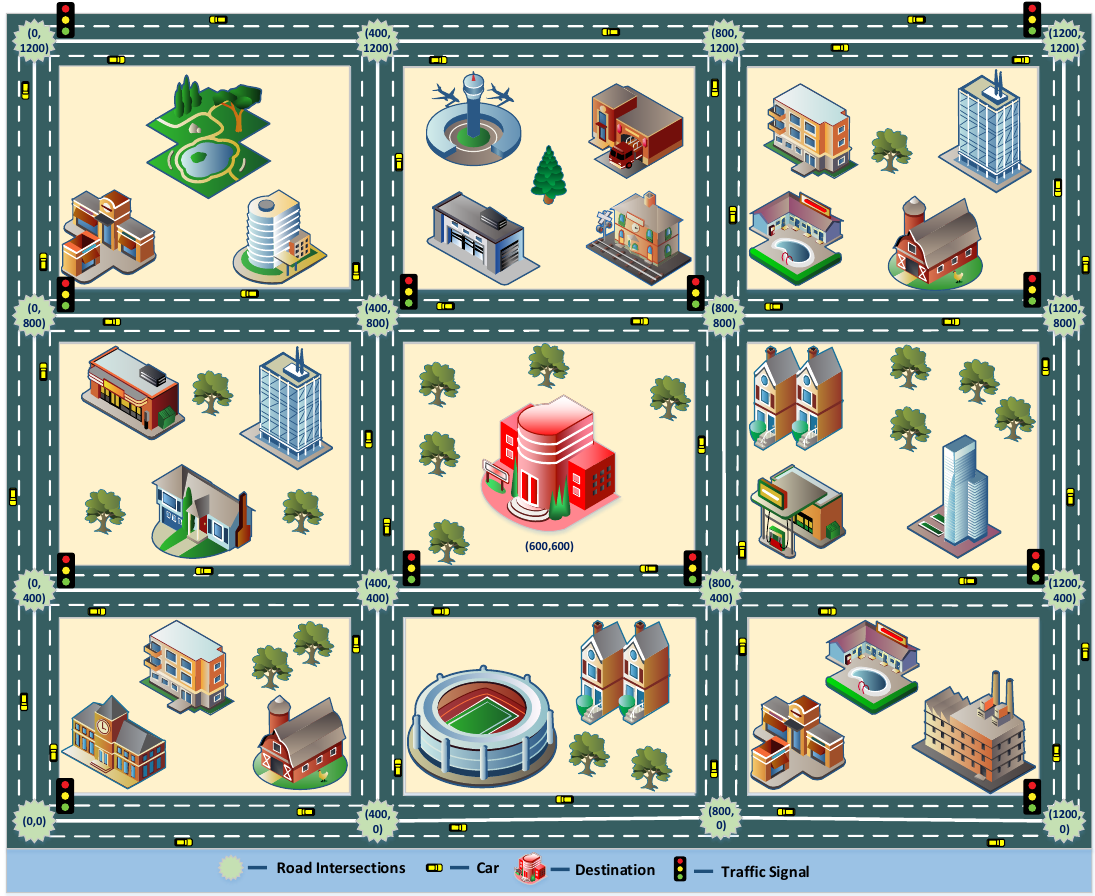
Figure 3. Illustration of the